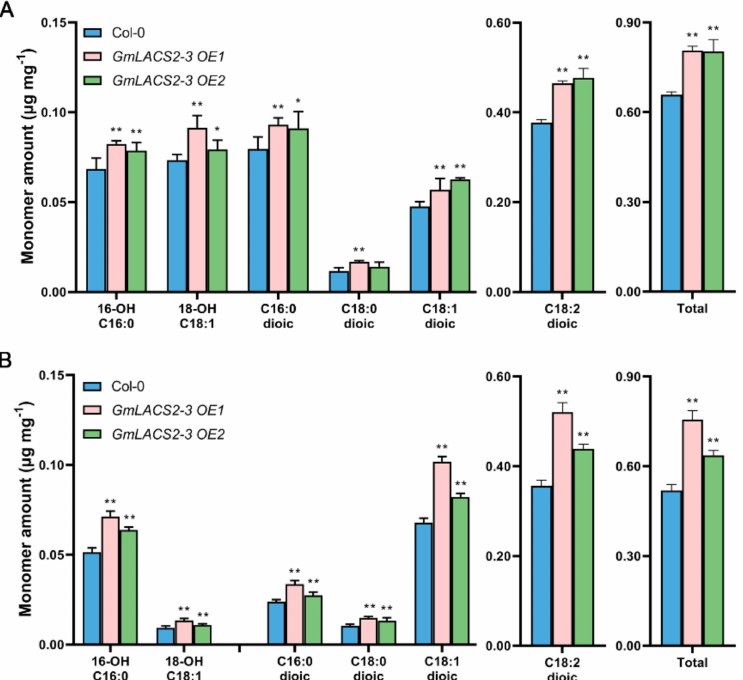
Figure 6. Cutin composition of leaf and stem of Arabidopsis wild-type Col-0, GmLACS2-3 OE1 , and GmLACS2-3 OE2 . The C16 and C18 labels on the x -axis represent the 16- and 18-carbon acid chains, respectively, whereas the number preceding “OH” indicates chain insertion point(s). Dioic represents dioic acid. The number of double bonds is indicated after the colon. Monomer amounts are expressed as µ g · mg − 1 leaf ( A ) and stem ( B ). The values shown are means ± SD ( n = 4). * and ** respectively indicate significant difference ( p < 0.05) and highly significant difference ( p <